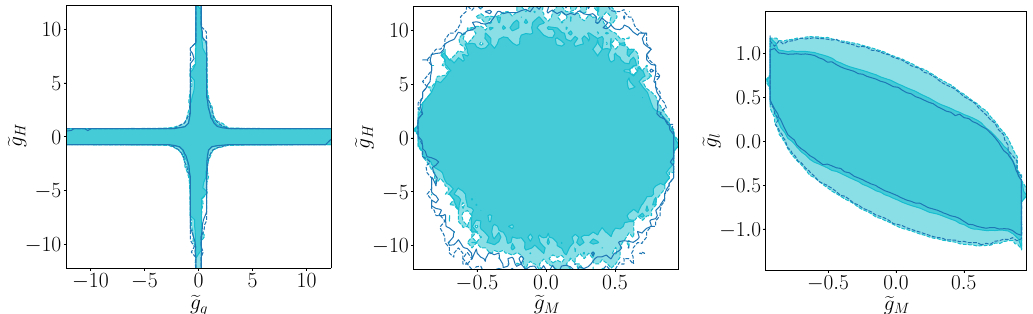
Figure 11: Impact of the high-energy kinematic distributions [ 81–83 ] on the global = 4TeV. The solid regions include the full data 5-parameter SMEFT fit for fixed m V set (same as Fig. 9), while the dark blue lines exclude the high-energy kinematic distributions. Solid (dashed) lines mark the ∆ χ 2 = 2.3 ( ∆ χ 2 = 5.991) contours. Variable matching